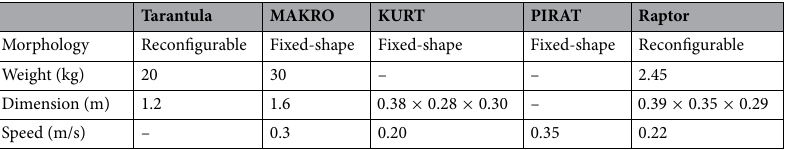
Table 6. Comparison with existing drain inspection